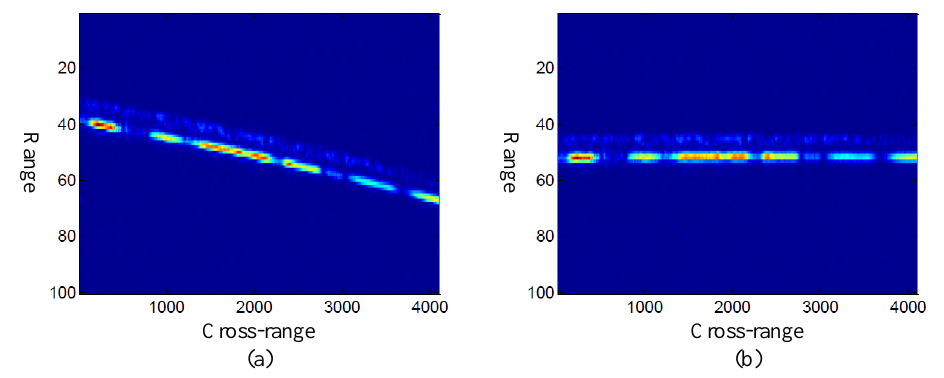
Figure 8. The envelope of T1. ( a ) Before correction. ( b ) After correction.